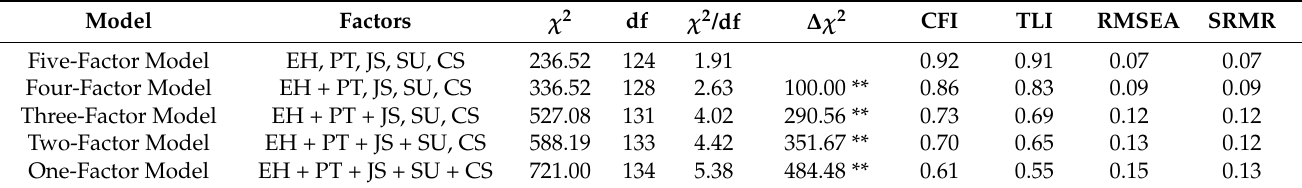
Table 1. Results of confirmatory factor analysis.